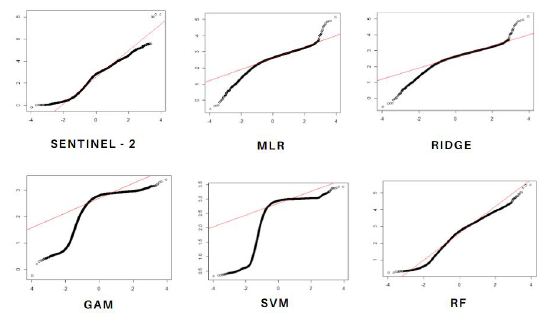
Figure 7. QQ Plots of Sentinel-2 derived LAI and estimated LAI values by each model.